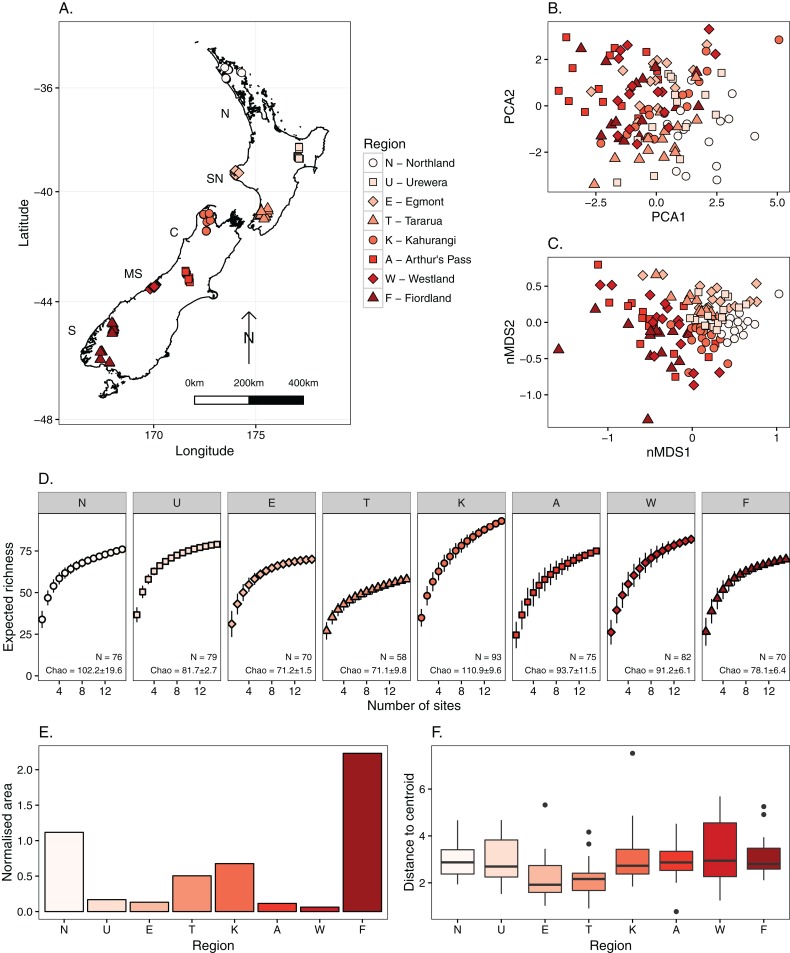
Overview of sites and regional invertebrate assemblages across New Zealand.All plots are colour-coded and shaped in the same manner, from north to south. (A) Distribution of 120 sites across eight regions of New Zealand. The five biogeographic regions are displayed as letters alongside the plot (N, Northern North Island; SN, Southern North Island; C, Central New Zealand; MS, mid-South Island; S, Southern South Island). (B) First two components of principal component analysis on environmental variables used in the study. Proportion of variation explained: PCA1 = 0.21; PCA2 = 0.17. (C) Non-metric multidimensional scaling ordination of invertebrate communities from all 120 sites. 2D stress = 0.21. (D) Species accumulation curves for all species for the eight regions. Regions are ordered from north (left) to south (right). Displayed text shows sampled regional richness (N) and Chao’s estimate of total regional richness with standard error. (E) Spatial extent of each metacommunity (normalised area). (F) Environmental heterogeneity of each metacommunity, measured through homogeneity of dispersions.